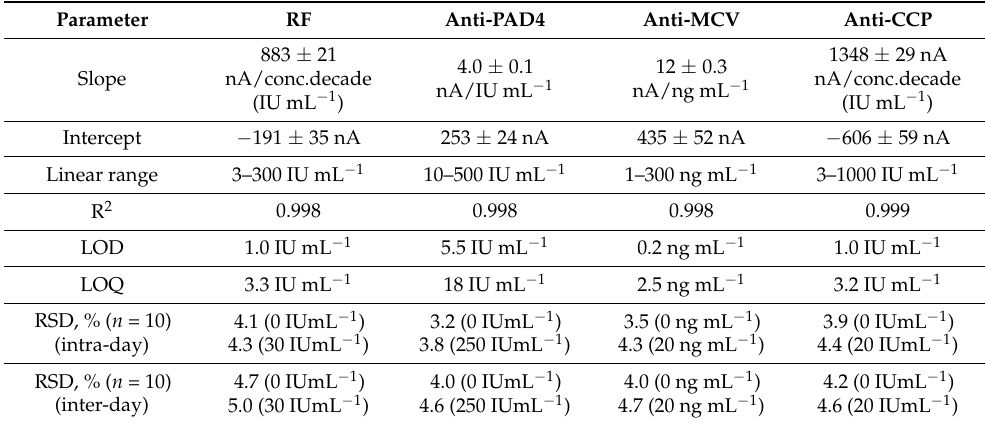
Figure 2. Calibration plots obtained with the quadruple immunoplatform for the simultaneous determination of ( a ) RF, ( b ) anti-PAD4, ( c ) anti-MCV, and ( d ) anti-CCP antibodies. Table 2. Analytical characteristics of the calibration plots for RF, anti-PAD4, anti-MCV, and anti-CCP constructed with the quadruple immunoplatform.